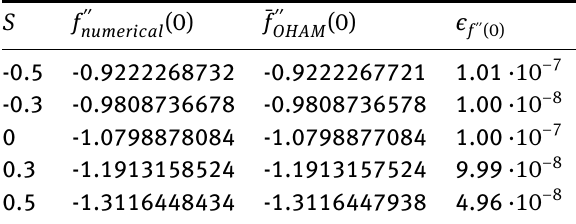
Table 6: Comparison between the skin-friction coefficient ¯ f ′′ (0) obtained by means of the OHAM and numerical results, for λ = 0.1 and different values of the suction/blowing parameter S (relative